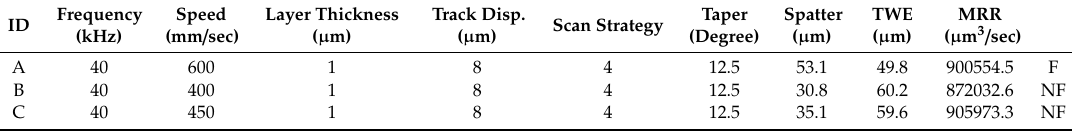
Figure 15. Optimal solution minimizing taper and spatter. Table 4. Optimum parameters minimizing taper angle and spatter of the microchannel.